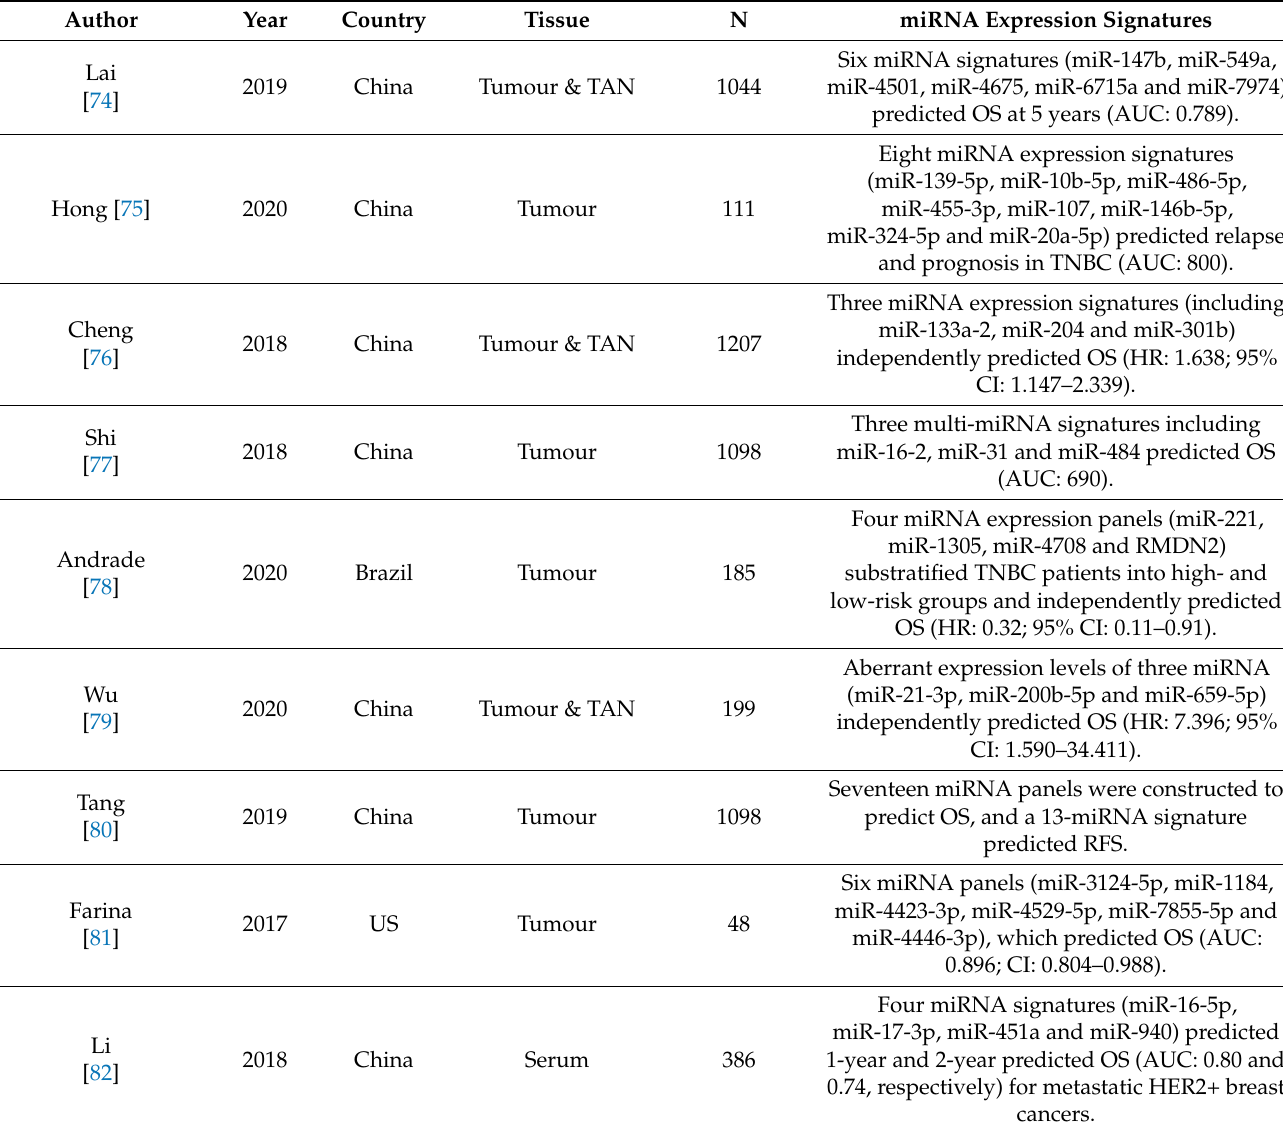
Table 3. miRNA signatures and their roles in predicting outcome in breast cancer